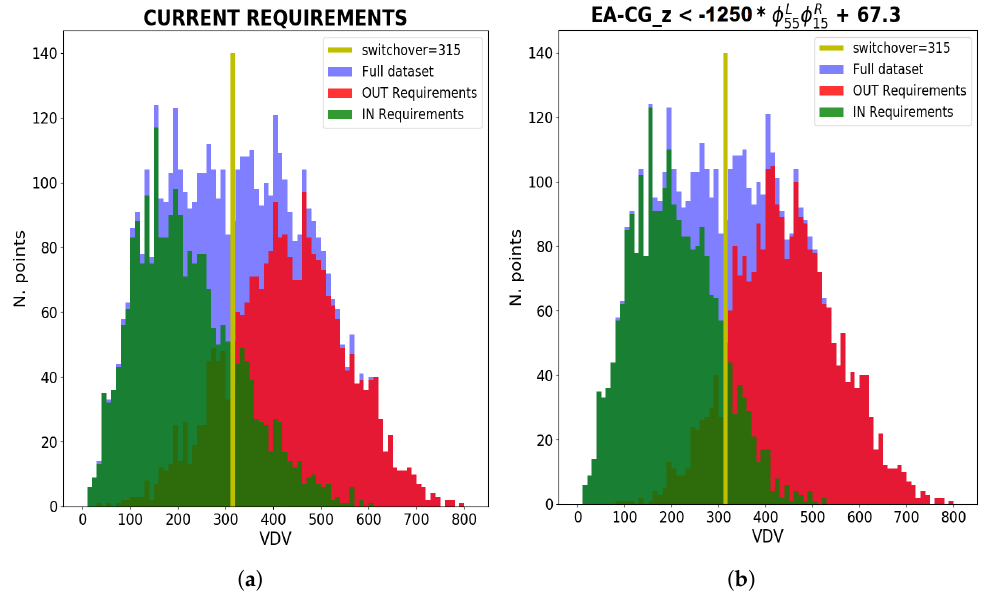
Figure 9. Specificity tests for ( a ) the benchmark and t ( b ) new requirements with q = 67.3 in relation to the switch-over